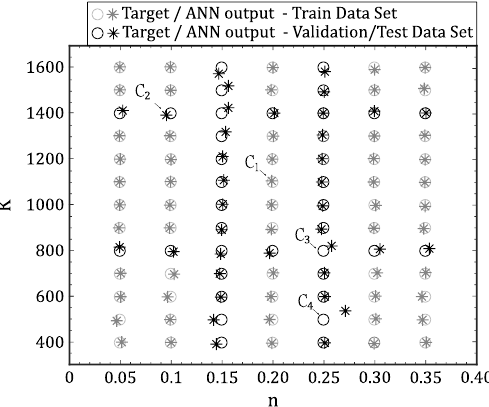
Figure 17. Graphical comparison between targets and ANN output values for the 91 K - n